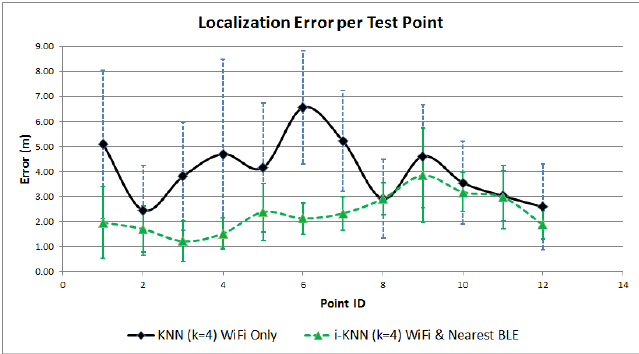
Figure 6. Positioning error comparison: Wi-Fi only vs. nearest BLE and